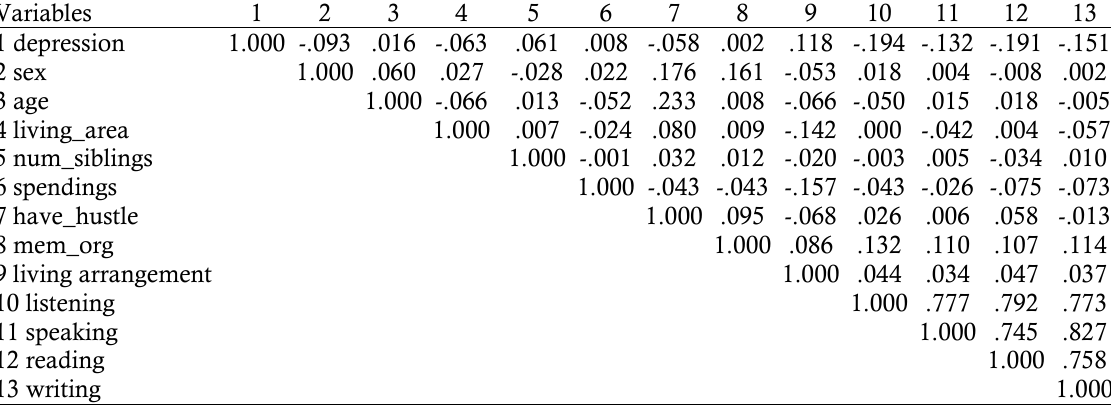
Table 2. Pearson correlation